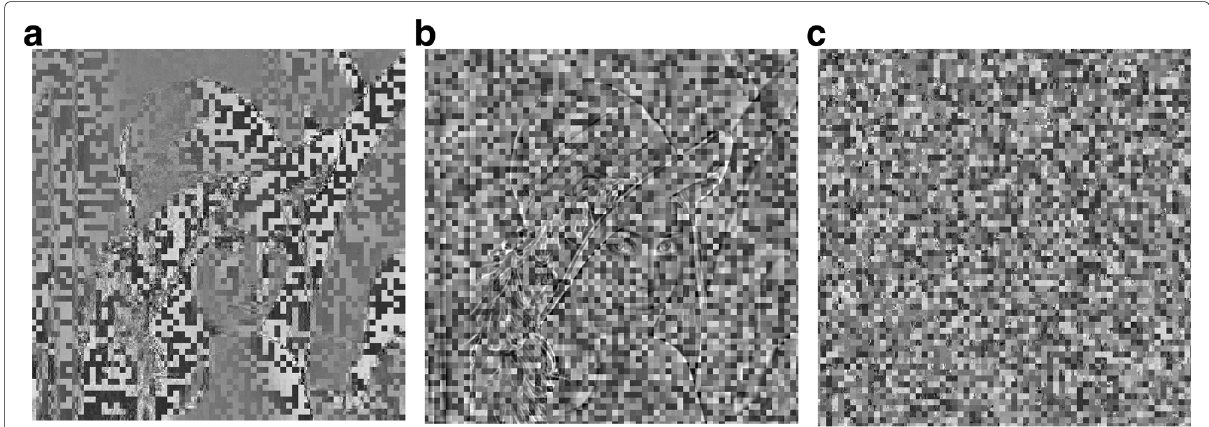
Fig. 6 Encrypting the marked Lena image in the DWT domain. a LL 3 coefficient sign bit encryption. b Permutation of LL 3 coefficients. c Permutation of 8 × 8 blocks